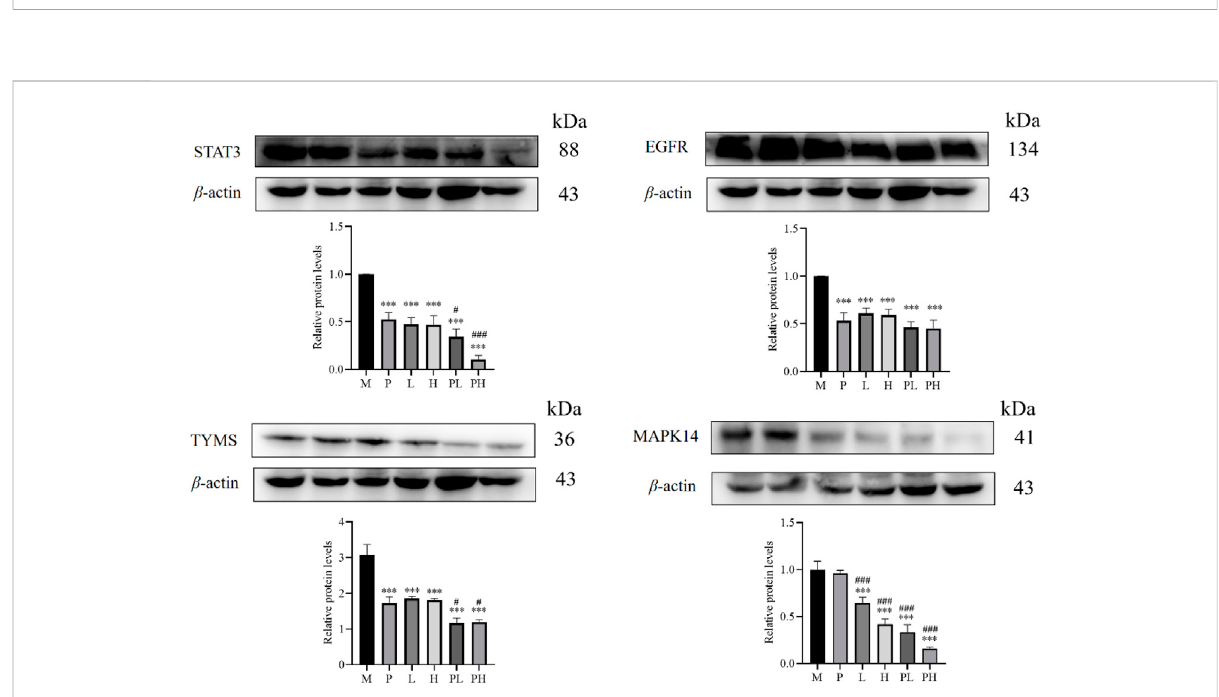
FIGURE 11 The effect of GYP and/or cisplatin on the protein levels of STAT3, EGFR, TYMS and MAPK14 in tumor tissues among M, P, L, H, PL and PH group. (M: model group; P: cisplatin group, L: low-dose GYP group, H: high-dose GYP group, PL: cisplatin + low-dose GYP group, PH: cisplatin